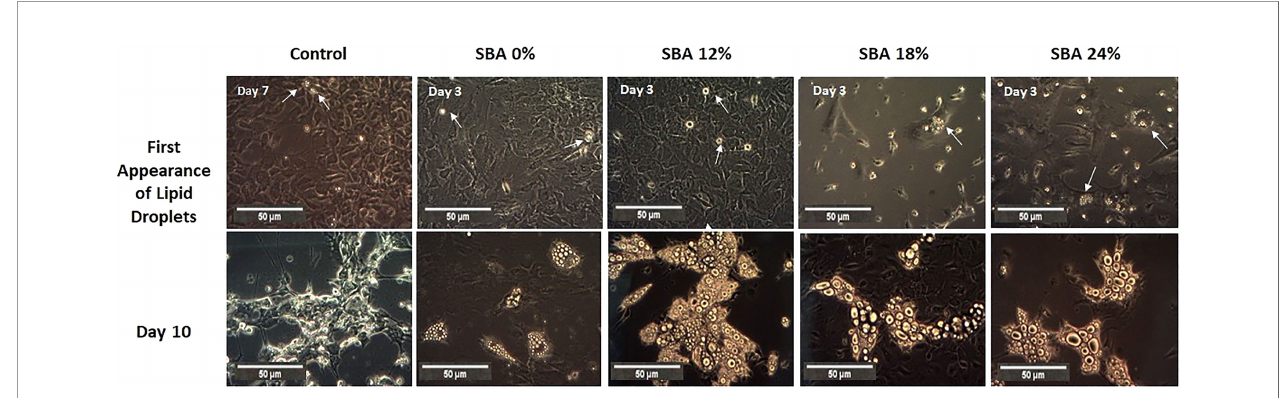
FIGURE 3 | Overview of adipocyte fi rst appearance and size. A. Light microscope images of cells from each condition were taken on different points of differentiation showing the fi rst appearance of lipid droplets and adipocytes at day